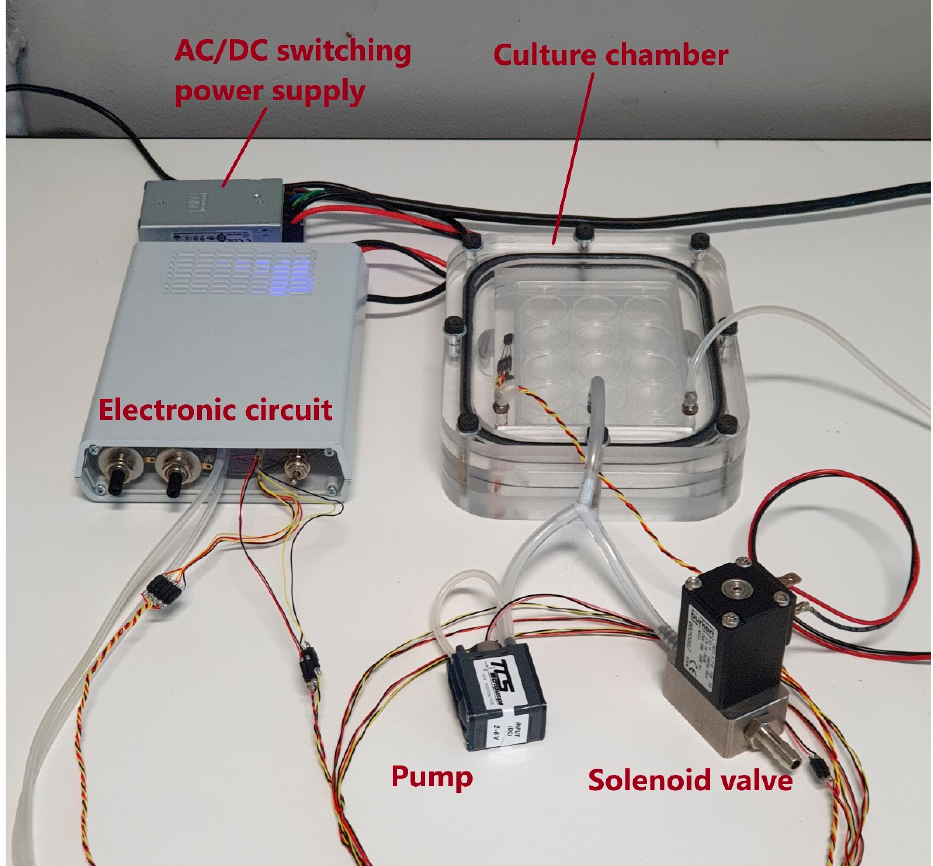
Figure 7. Complete system mounted, with all its main parts.